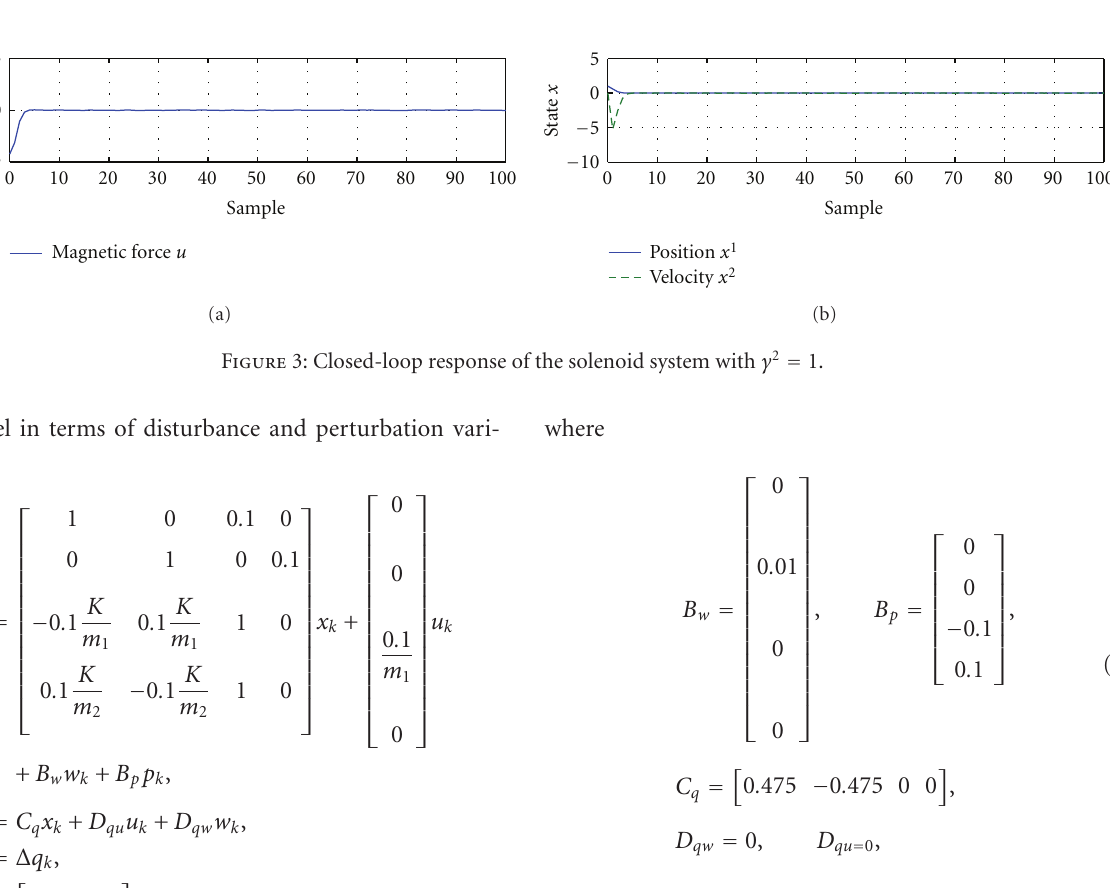
Figure 2: Closed-loop response of the solenoid system with γ 2 = 0 . 01.